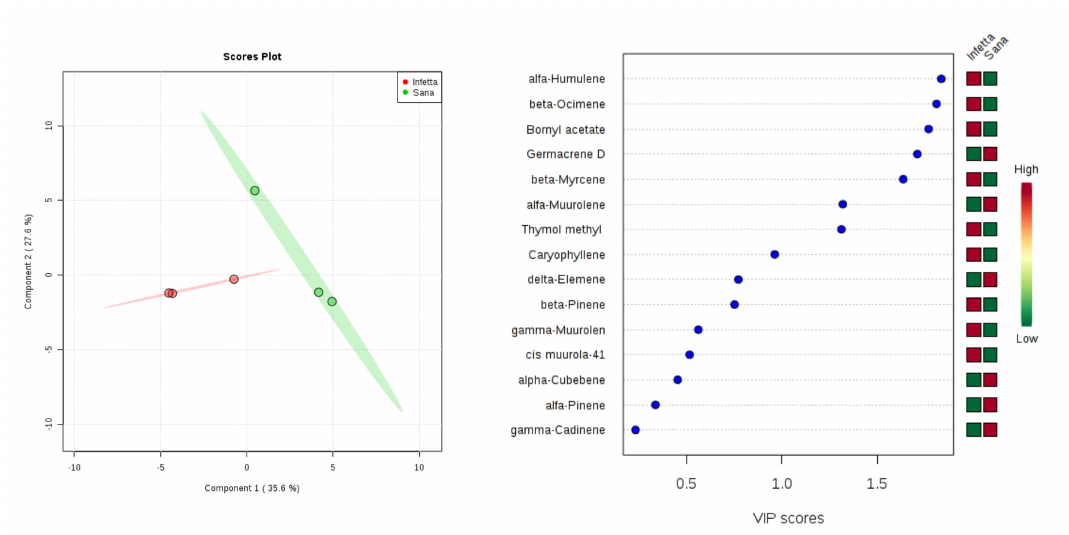
Figure 5. Partial least squares discriminant analysis applied to the Sampling #2 (DEFO-1) in Bova. Parameters and symbols as in Figure